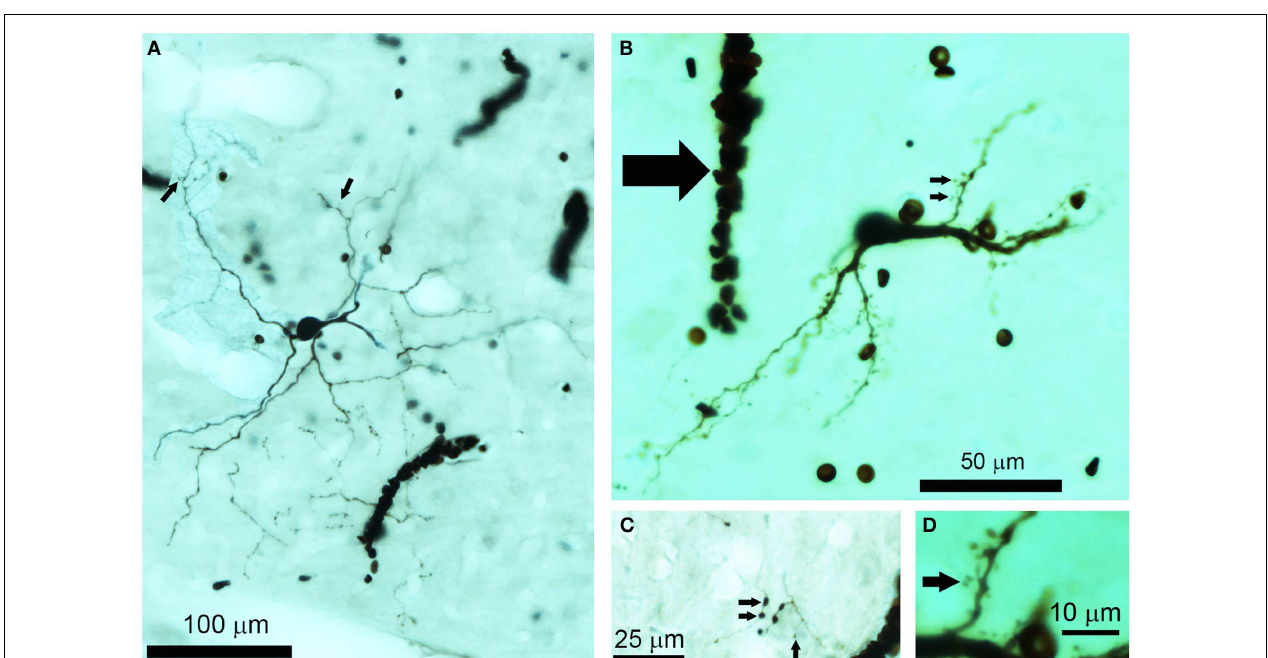
that filled up with blood during the removal of the electrode (large arrow). (C) The disk cell shown in (A) had an axon with numerous axonal swellings some of which were quite large (2 µ m diameter) as indicated by the pair of small arrows, but nearby there were other small axonal endings ( < 1 µ m) as indicated by the single small arrow. (D) A higher power view of the dendritic spines indicated by the lower small arrow in (B) .These are only about 20 µ m from the soma and have a long thin